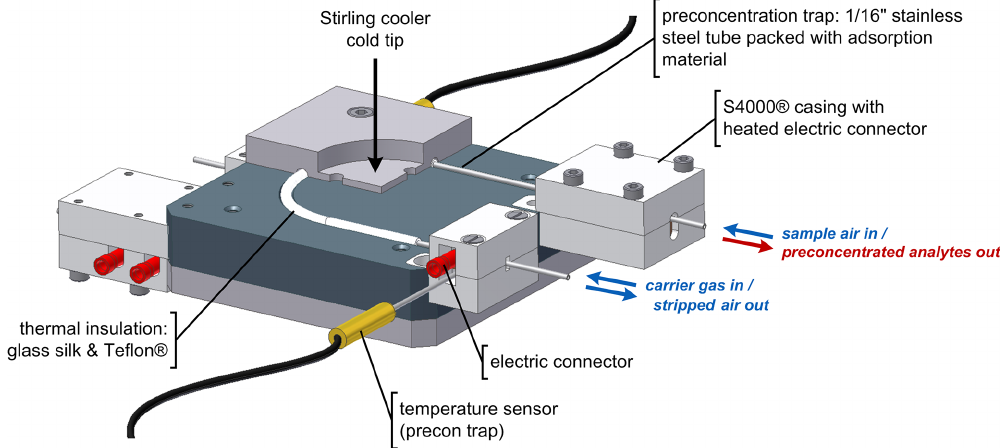
Figure 2. Technical drawing of the coldhead and preconcentration trap placed inside. Three plates of anodised aluminium can hold two traps. The Stirling cooler’s cold tip screwed to the coldhead removes heat for cooling. Heat for sample desorption is generated by a current directly applied to the tubing of the trap. The electric connector in the direction of sample flow (upper right side of the drawing) is heated constantly to 150 ◦ C to avoid a cold point due to the mass of the electric connector and its proximity to the coldhead (S4000 ® insulation material: Brandenburger,